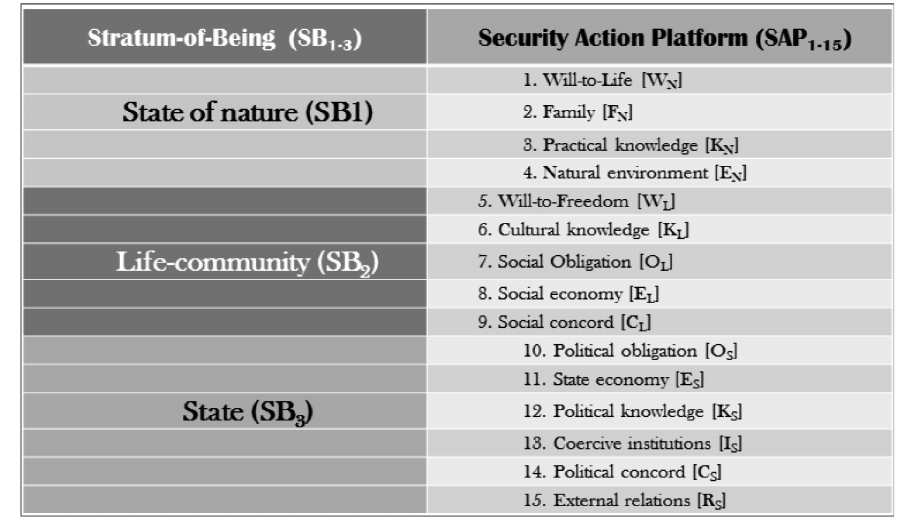
Figure 5: Summary of Anthrocentric Security Theory